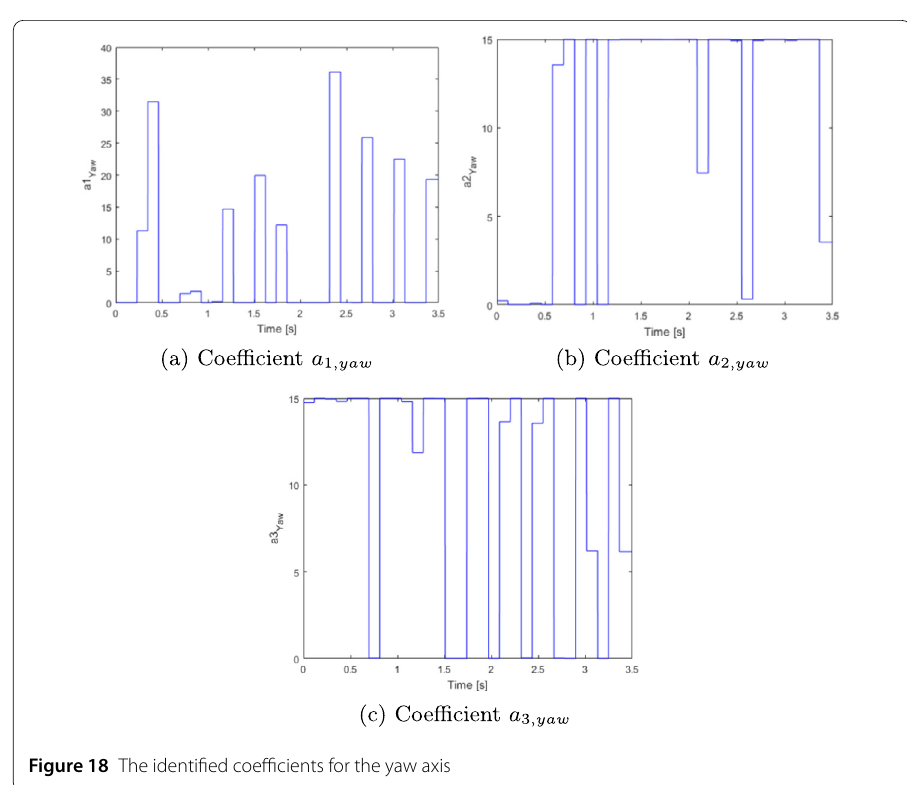
Figure 18 The identified coefficients for the yaw axis